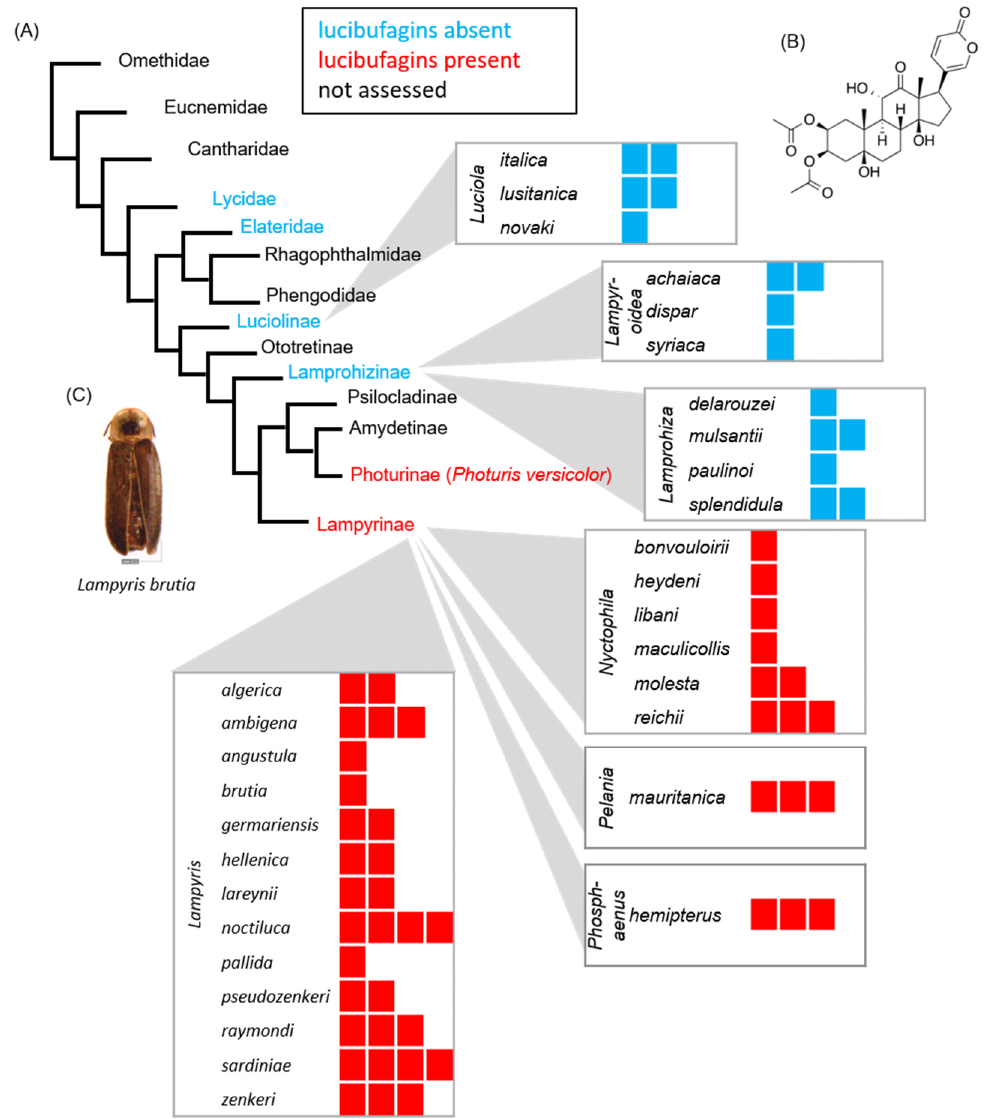
Figure 1. Distribution of lucibufagins (i.e., bufadienolides) in fireflies based on the chromatographic analysis of museum specimens. ( A ) 31 palearctic species of fireflies (Lampyridae) were assessed for the occurrence of defensive lucibufagins. Red rectangles represent beetle specimens that tested positively for lucibufagins, blue rectangles represent beetle individuals that were devoid of these compounds. Further occurrences of bufadienolides are known from Photuris versicolor (Photurinae) [14], Diaphanes lampyroides [17], Ellychnia corrusca [16], Lucidota atra [15], Photinus ignitus, P. marginellus [9,12], and P. pyralis (Lampyrinae) [11,12]. Absence of lucibufagins was further demonstrated for Aquatica lateralis (subfamily Luciolinae) and the click beetle Ingnelater luminosus (Elateridae) [24]. Coloration of family or subfamily names either indicates presence (red) or absence (blue) of bufadienolides based on literature research and our own evaluation. Phylogenetic relationships are based on Martin et al. [34]. ( B ) Lucibufagin C, a firefly bufadienolide found in Photinus pyralis [11]. ( C ) Extracted specimen of Lampyris brutia , collected in 1905. Table 1. Total amounts of lucibufagins and diversity of structurally different lucibufagins based on HPLC-DAD. Individ- ual lucibufagin contents are separated by slashes if more than one specimen was analyzed (second column). Diversities of individual lucibufagins (third column) are listed in the same manner. Note that only positively screened species are listed in the table.